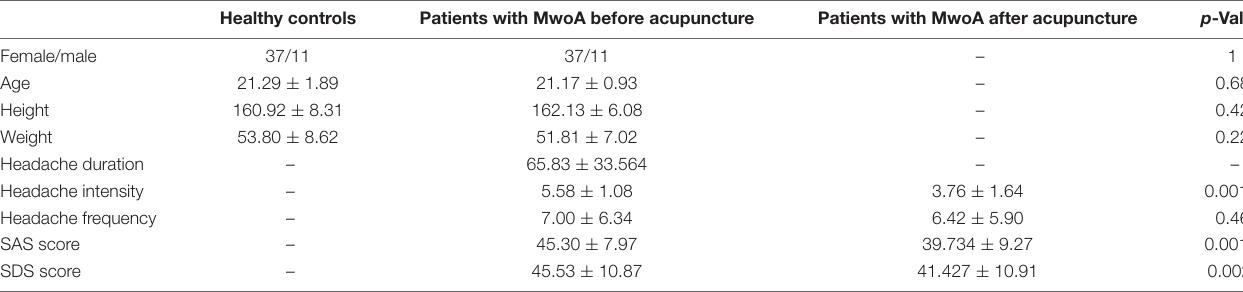
TABLE 1 | Demographic and clinical data of patients with migraine and healthy controls.